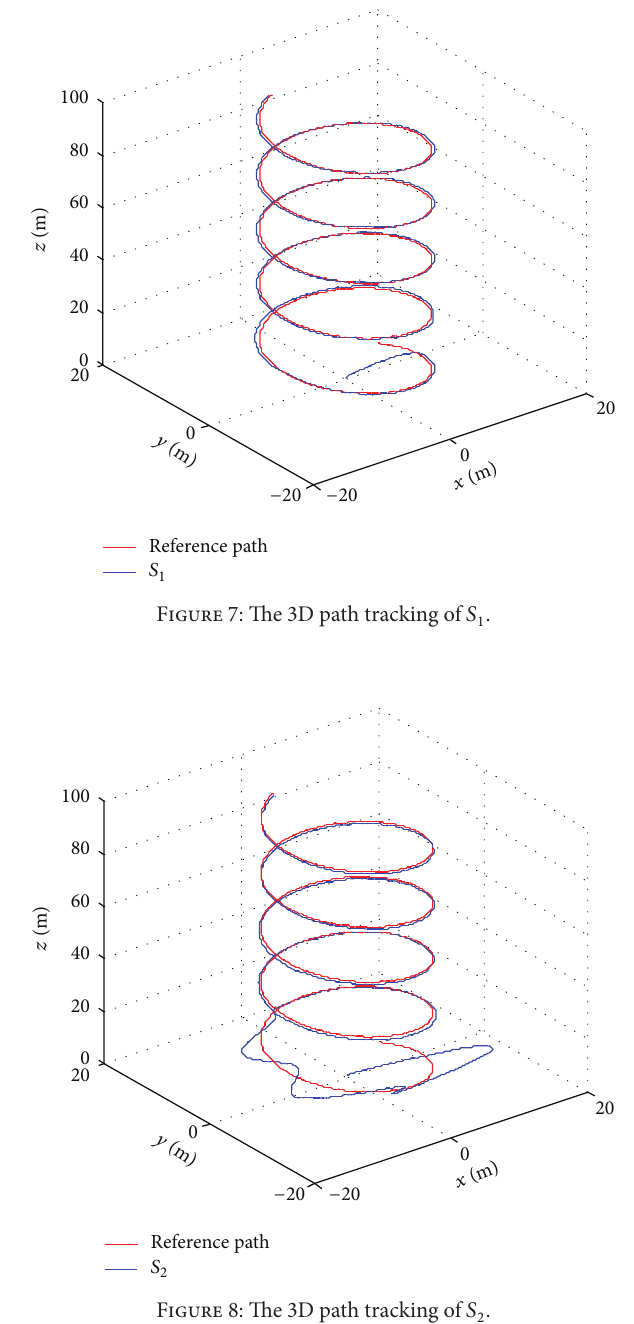
Figure 8: The 3D path tracking of 𝑆 2 .